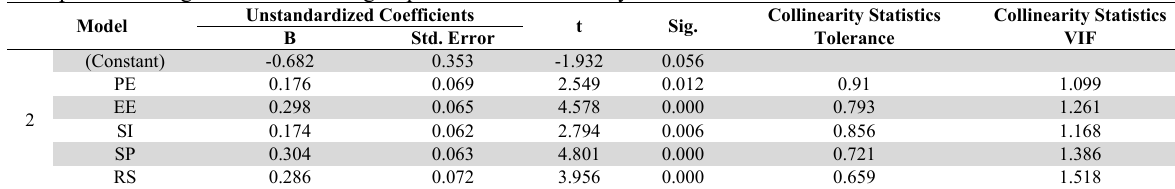
Multiples linear regression model for groups of customers already in use Model